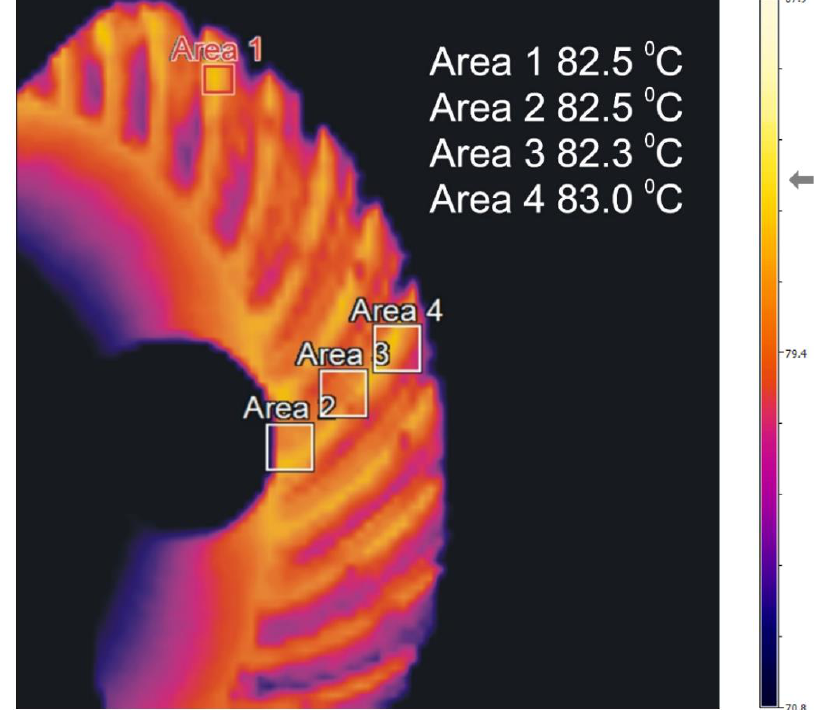
Figure 15. Distribution of temperature in the face gear, measurement number 8.